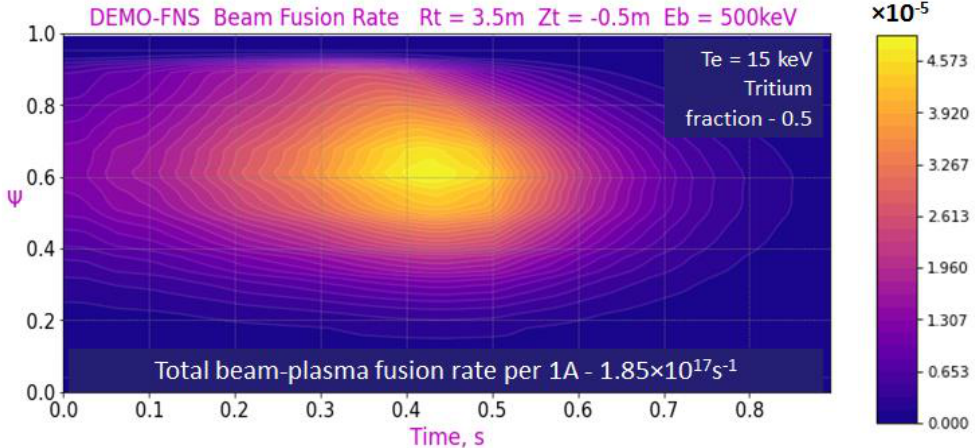
Figure 4. Color map of weighted fusion rate (1/s) evolution in time, calculated with account of beam ions ( E b = 500 keV) actual deposition in DEMO-FNS plasma for external off-axis beam injection. Plasma profiles are the same as shown in Figure 3b, tritium fraction is 0.5. The evaluated neutron yield from 1A of NBI is 1.85 × 10 17 1/c.